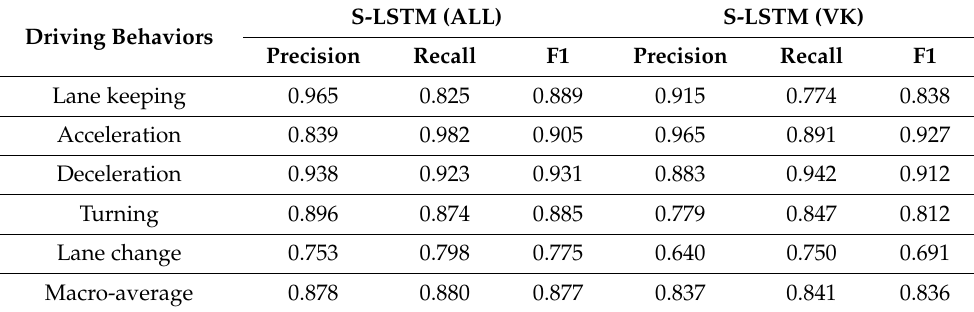
Table 5. Identification results of different input features.